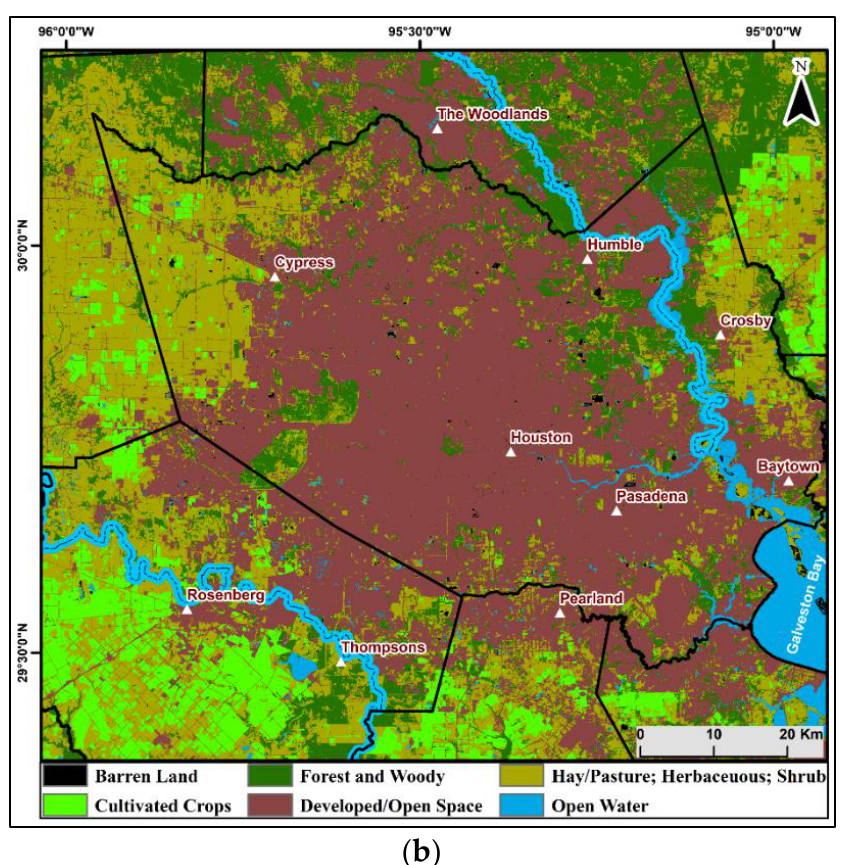
Figure 1. ( a ) The study area, including Houston city and parts of the surrounding areas (counties Harris, Fort Bend, Waller (partial), Montgomery (partial), Liberty (partial), Brazoria (partial), and Galveston (partial)). The two rivers (San Jacinto and Brazos) that cut through the northeastern and southwestern parts along with the respective watersheds (West Fork San Jacinto and Lower Brazos, respectively, shown with dotted black lines), and surface elevation data retrieved from a digital elevation model (DEM) are also shown. The inset shows the location of the study area in the USA. ( b ) Land cover distribution map derived from the National Land Cover Database (NLCD; [44]). The landcover classes were re-grouped into the six major dominant land cover types prevalent in the study area.